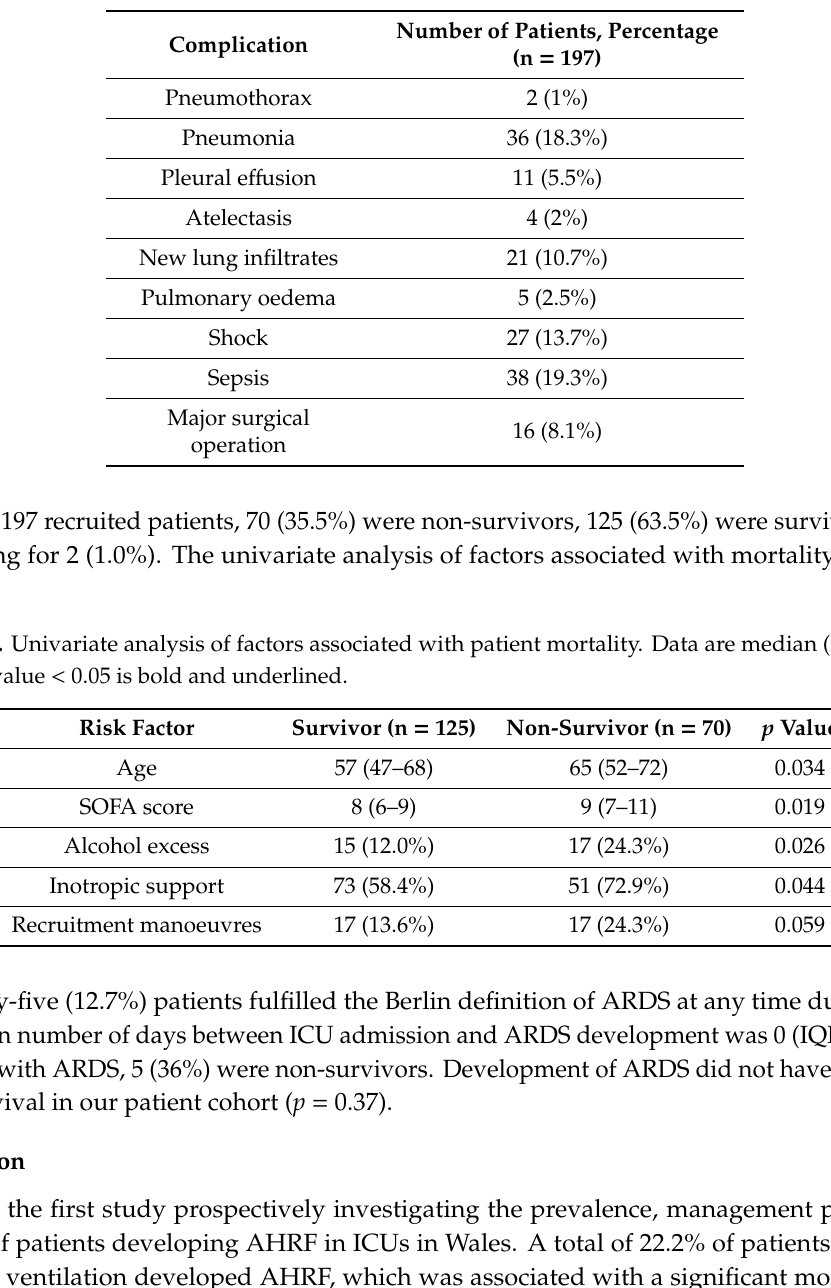
Table 4. Complications developed by enrolled patients. Data are presented as n (%).